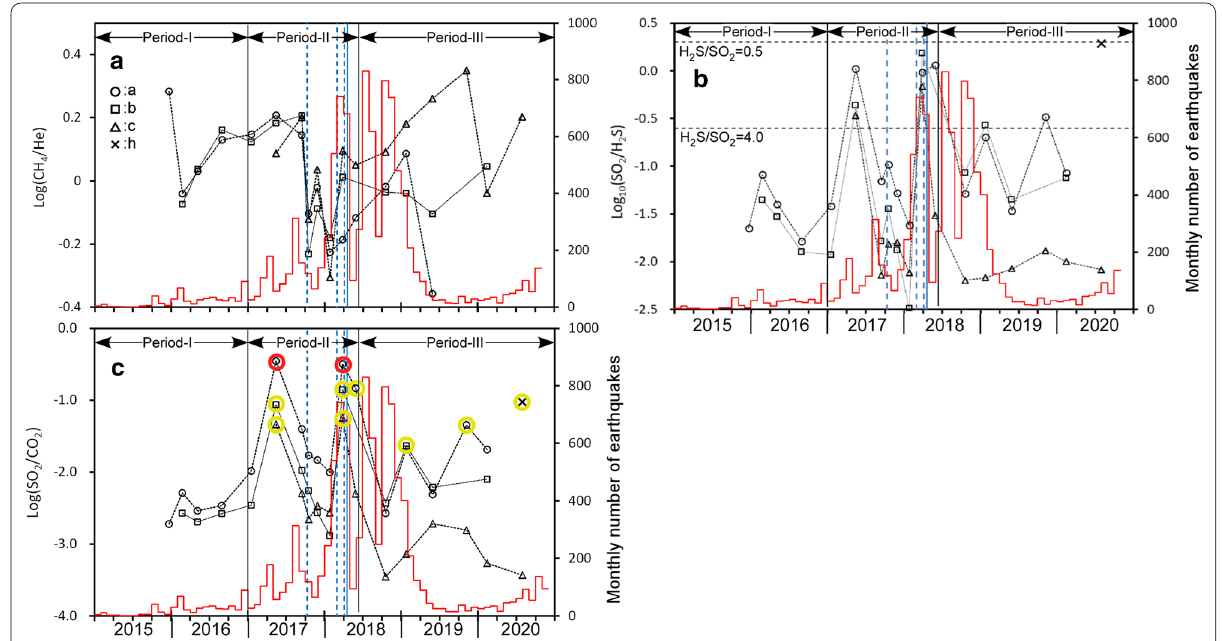
Fig. 11 a Changes in the CH 4 /He molar ratio of fumarolic gas. b Changes in the SO 2 /H 2 S molar ratio of fumarolic gas. The y-axis values of 0.5 and 4 for H 2 S/SO 2 ratio were indicated by the two horizontal broken lines. c Changes in the SO 2 /CO 2 molar ratio of fumarolic gas. Fumarolic gases surrounded by red and yellow circles are classified as being of shallow hydrothermal magmatic (SHM) and deep hydrothermal magmatic (DHM) origins, respectively. Red histogram and vertical lines are the same as in Fig.